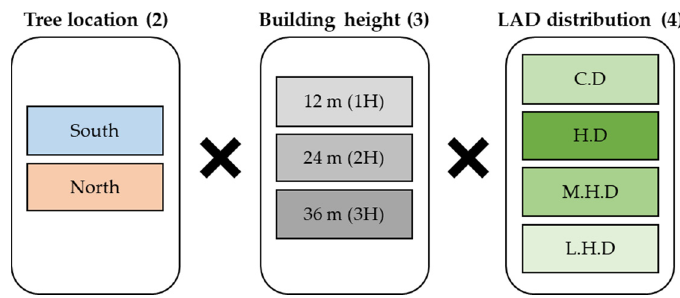
Figure 4. Settings of scenarios for simulation. The total number of scenarios is 24.